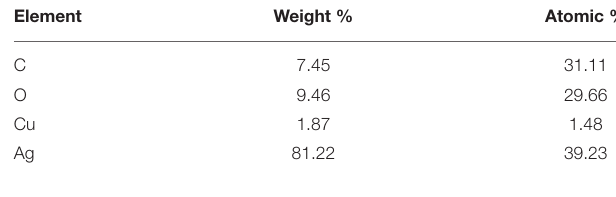
TABLE 1 | EDAX analysis of biogenic silver nanoparticles.